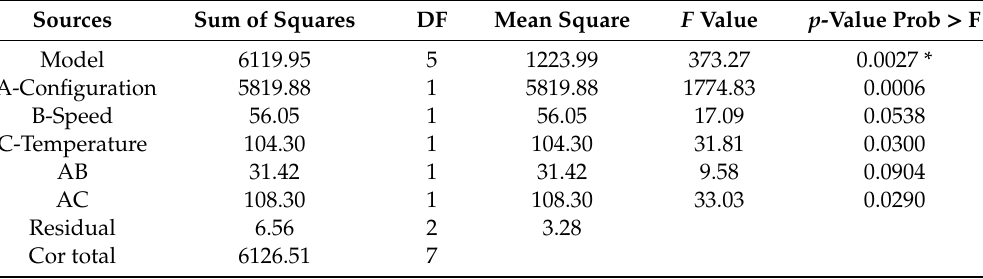
Table 4. ANOVA table drug release (Design Expert ® software).